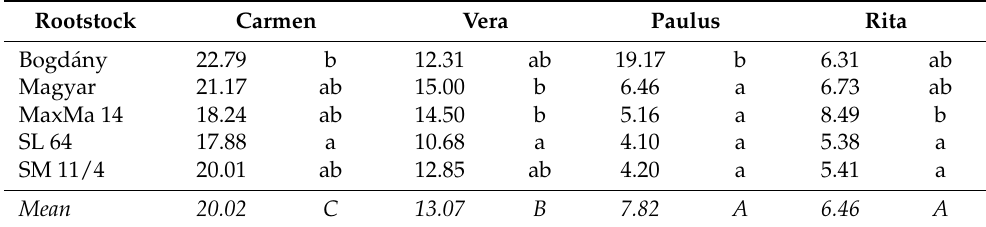
Table 5. Cumulative yield of trees (kg/tree) in the first three cropping years (2017–2019).